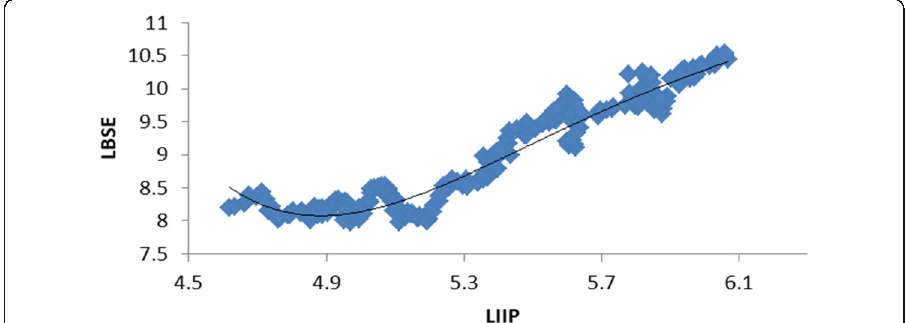
Fig. 1 Scatter Plot of LBSE and